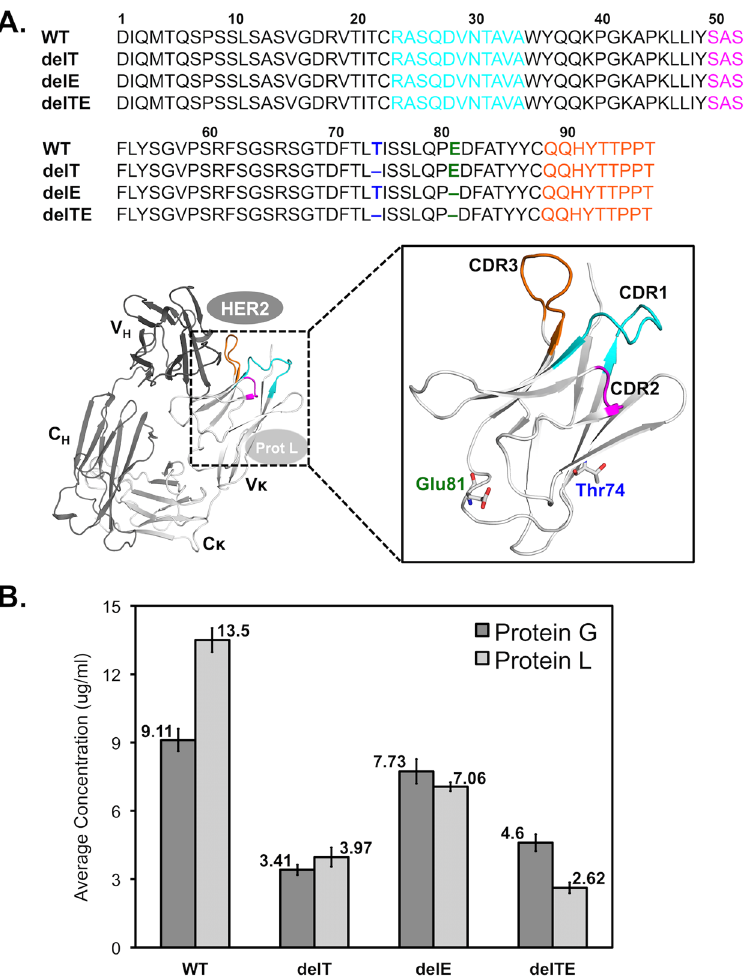
Figure 1. The Trastuzumab mutants (WT, delT, delE, delTE) used in this study ( A ) Sequence alignments of the Trastuzumab mutants with CDRs highlighted as follows: V κ -CDR1 (cyan), V κ -CDR2 (magenta), and V κ - CDR3 (orange). The deleted residues T74 and E81 are in blue and green, respectively. The structure of the WT- Fab region is shown in dark gray (heavy chain) and in light gray ( κ light chain). Schematics of Her2 binding (at CDRs) and protein L binding (at V κ -FWR1) are shown. ( B ) Antibody secretion levels of Trastuzumab mutants as determined by Protein G and L biosensor. Each bar shows the average concentration ( μ g/ml) of Trastuzumab WT and mutants in cell culture supernatants from three independent experiments using protein G and protein L biosensors, followed by statistical analysis using ANOVA and two tailed T-Test. The ANOVA and T-test results showed that the mutants are significantly different from one another ( p < 0.05) within each biosensor data set (i.e. Protein L or